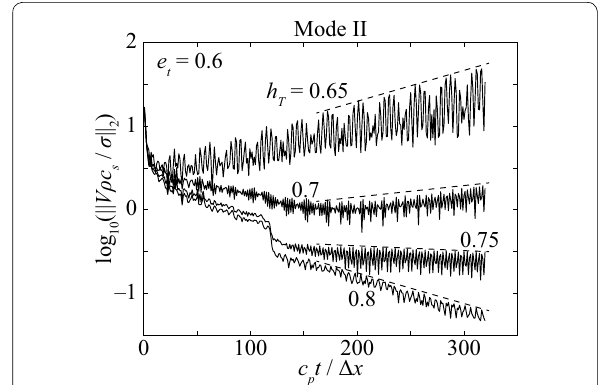
Fig. 3 Representative simulation results of the numerical stability analysis using CM for a Mode II problem and with e t = 0.6 and h T = 0.65, 0.7, 0.75, and 0.8 . The straight dashed lines are envelopes that define the growth